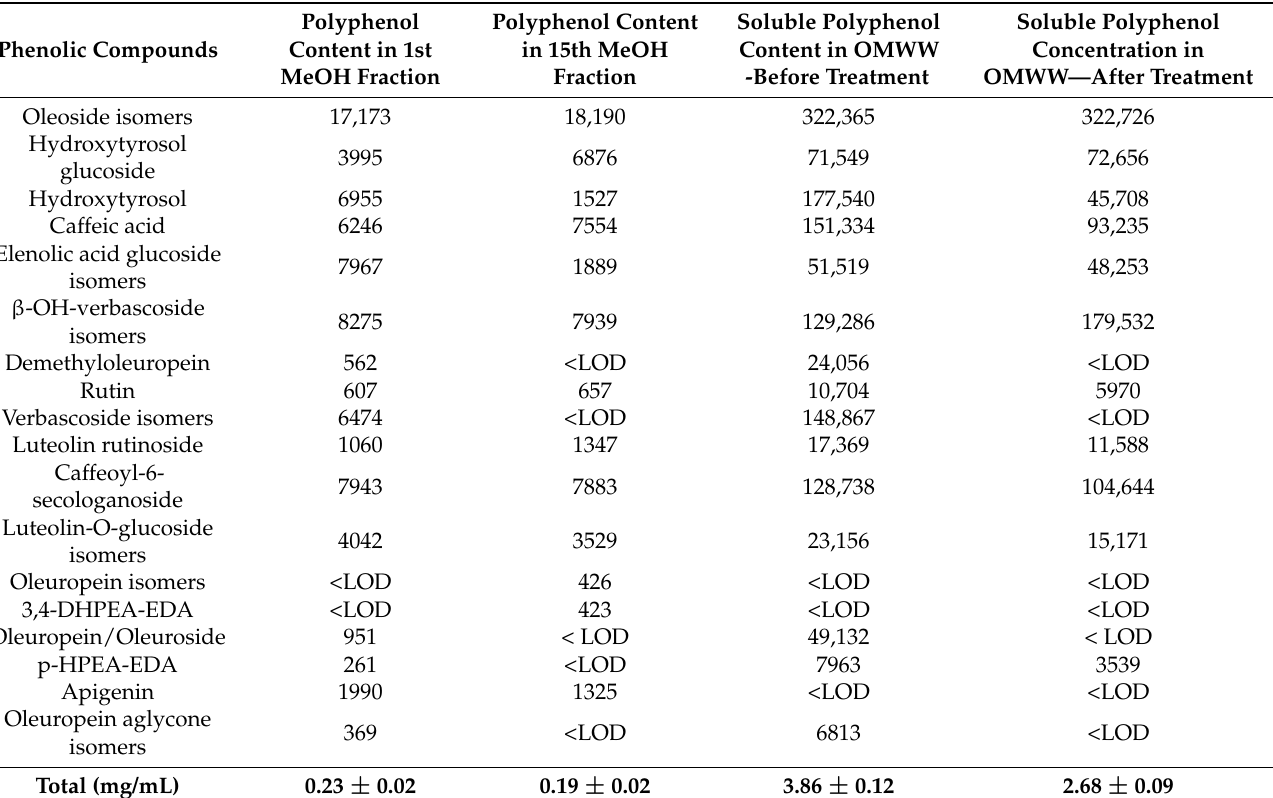
Table 3. Fifteen subsequent treatments of OMWW with unmodified Fe 3 O 4 particles. The particles were thereafter desorbed in MeOH. Total concentrations are quantified in mg per mL of OMWW, individual compounds are semi-quantified (counts on the MS